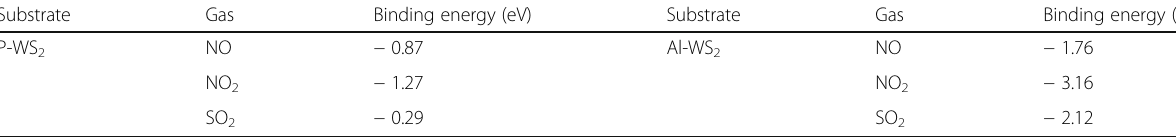
Table 1 Binding energy of P- or Al-doped WS 2 with gas adsorption on the energetically favorable site Substrate Gas Binding energy (eV) Substrate Gas Binding energy (eV) P-WS